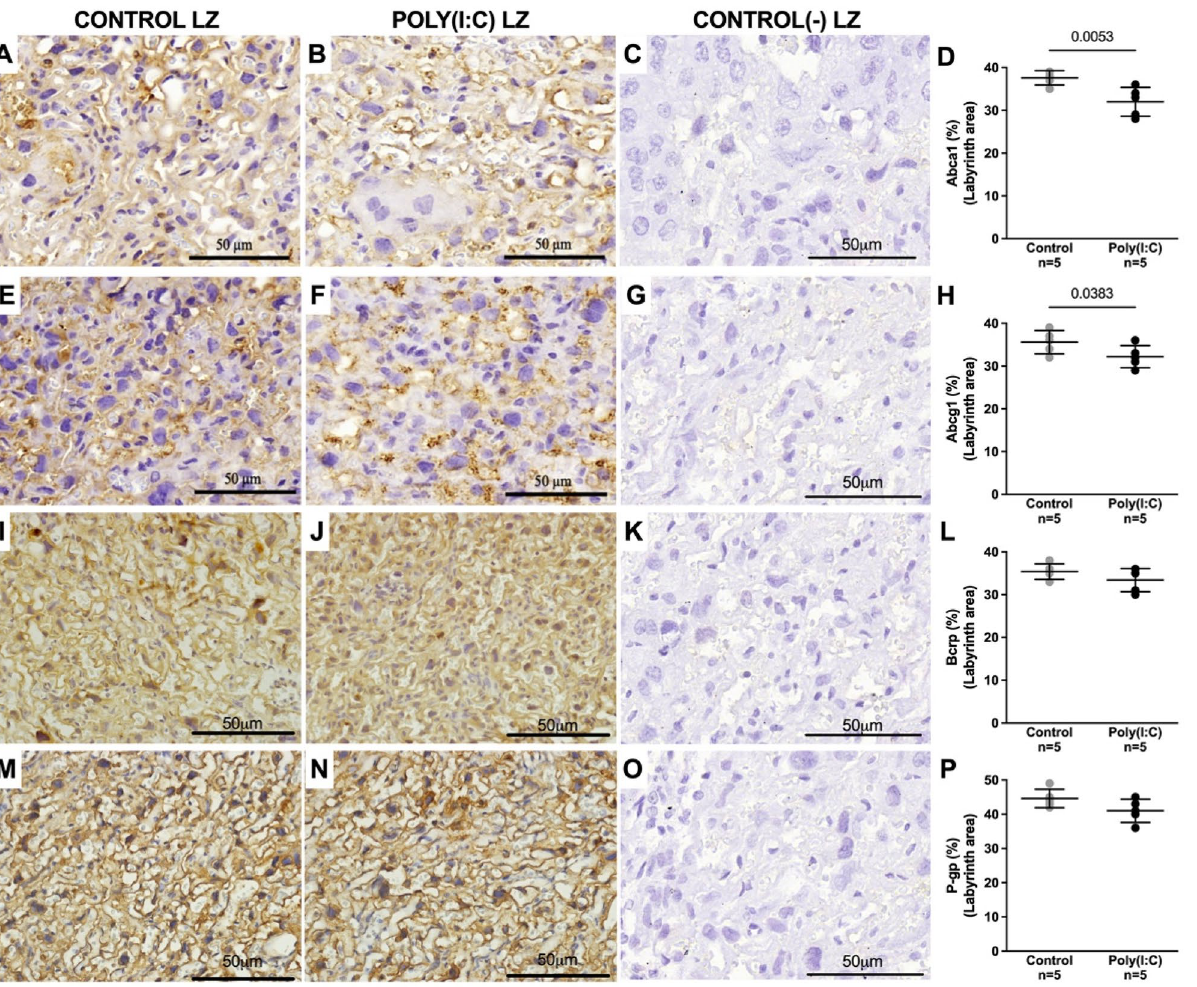
Figure 4. Mid-pregnancy poly(I:C) reduces Abca1 and Abcg1 immunostaining in the placental labyrinth zone (Lz) at term. Representative images of Abca1 ( A – D ), Abcg1 ( E – H ), Bcrp ( I – L ) and P-gp ( M – P ) staining and their respective quantification. Graphs were plotted in aligned dot plot, the gray circles represent the control group, and the black circles represent the poly(I:C) group. The Lz’s negative controls ( C , G, K and O ) were performed with the omission of the primary antibody. Values are expressed as mean ± SD. Student’s t test was